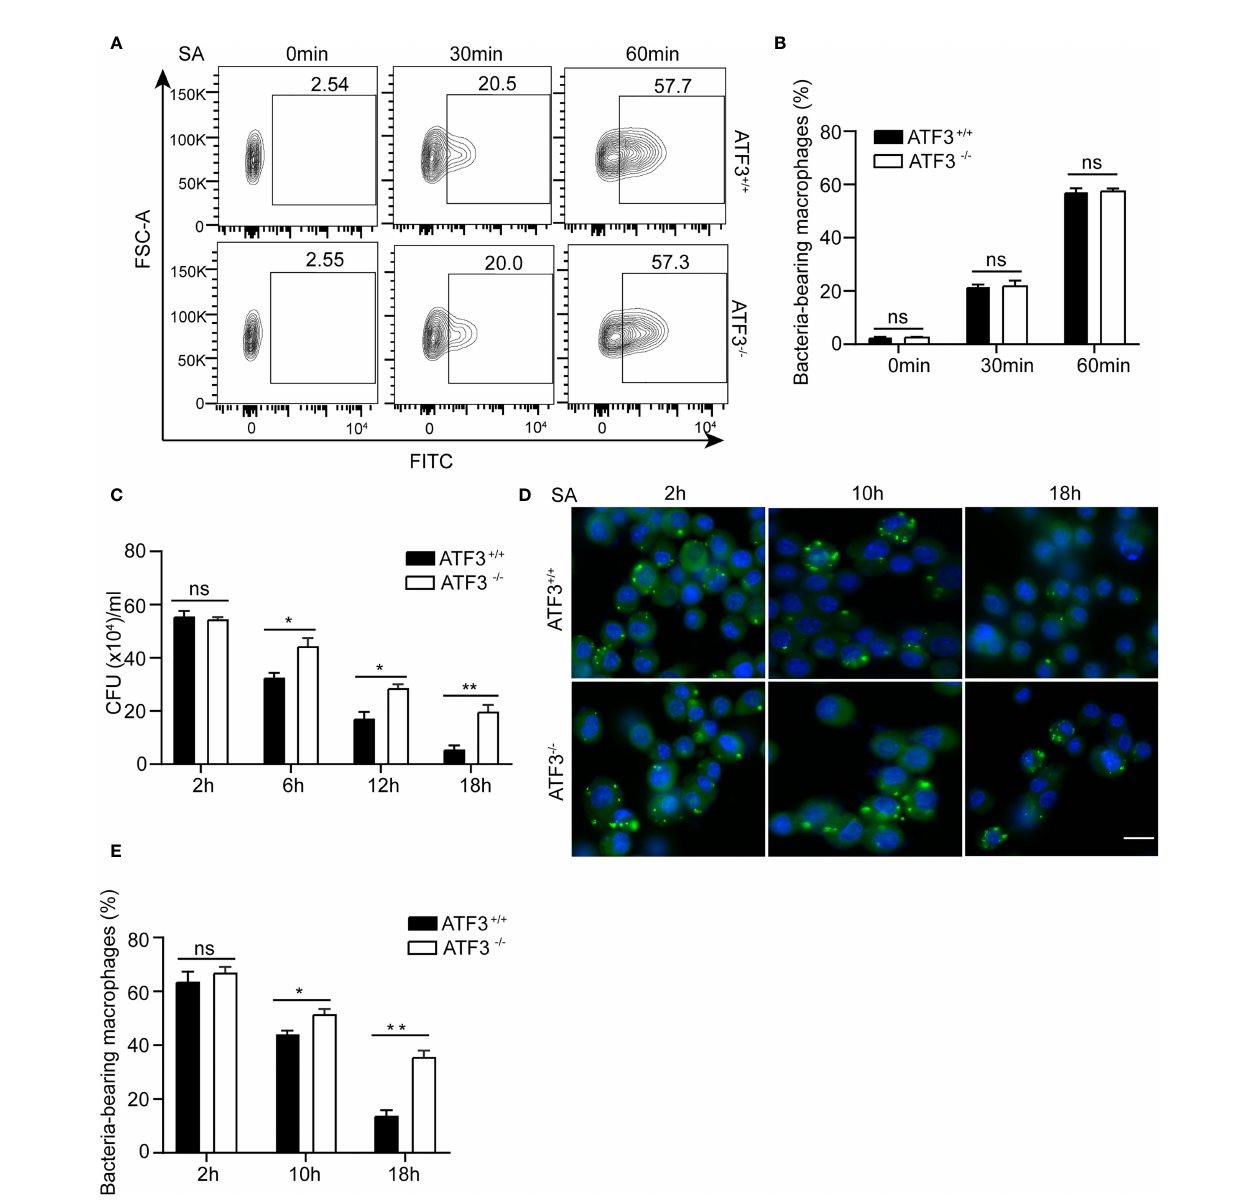
FIGURE 3 | ATF3 enhances macrophage bacterial clearance ability. WT and ATF3 KO BMDM cells were infected with S. aureus (MOI = 1) for the indicated time periods. (A, B) The phagocytic ability was evaluated by taking up the percentage of macrophages with CFSE-labeled S. aureus . Representative plots and quanti fi cation by bar graphs from fi ve independent experiments of fl ow cytometry are shown. (C) The bacterial load was measured and calculated in BMDM cells within the indicated time period after infection. (D, E) Intracellular bacteria measured by immuno fl uorescence microscopy. At 2, 10, and 18 h after infection, the uptake of S. aureus in BMDM cells is marked by CFSE (green). The nuclei are stained with DAPI (blue). Five representative images of each group were analyzed. Scale bar, 30 m m. ns, P > 0.05, * P < 0.05, ** P <